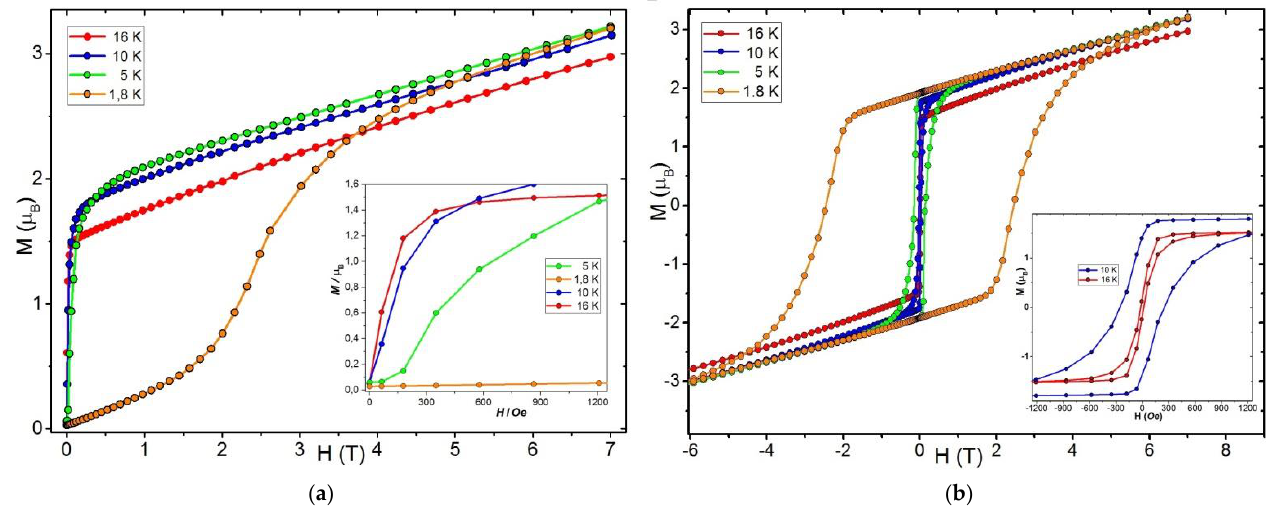
Figure 24. Magnetization plots for 15 measured on a polycrystalline sample at various tempera- tures and a field sweep rate of 700 Oe/s. ( a ) Initial magnetization plots. ( b ) Magnetic hysteresis loops. Inset the zoomed-in low-field region for the data collected at 10 and 16 K [56].